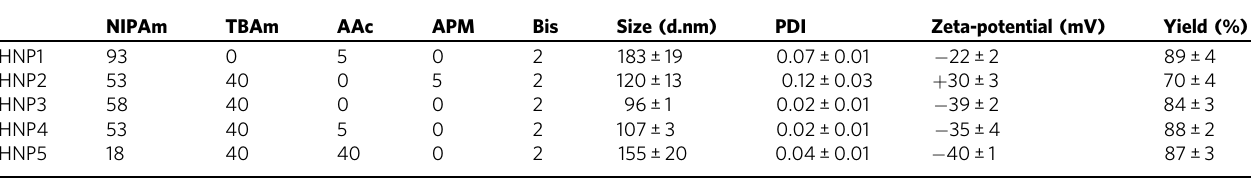
The monomer structures can be found in Fig. 1a. Data represent the means±s.d. n = 3.